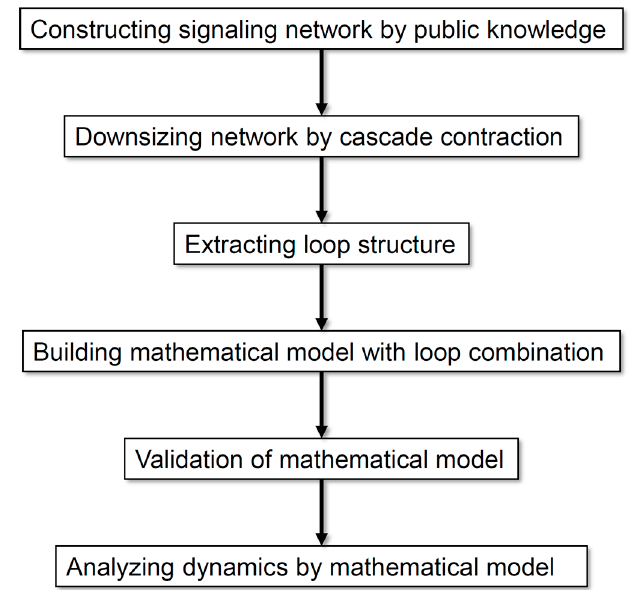
Figure 1 . Flow diagram of the analysis processes employed in this study. Figure 1. Flow diagram of the analysis processes employed in this